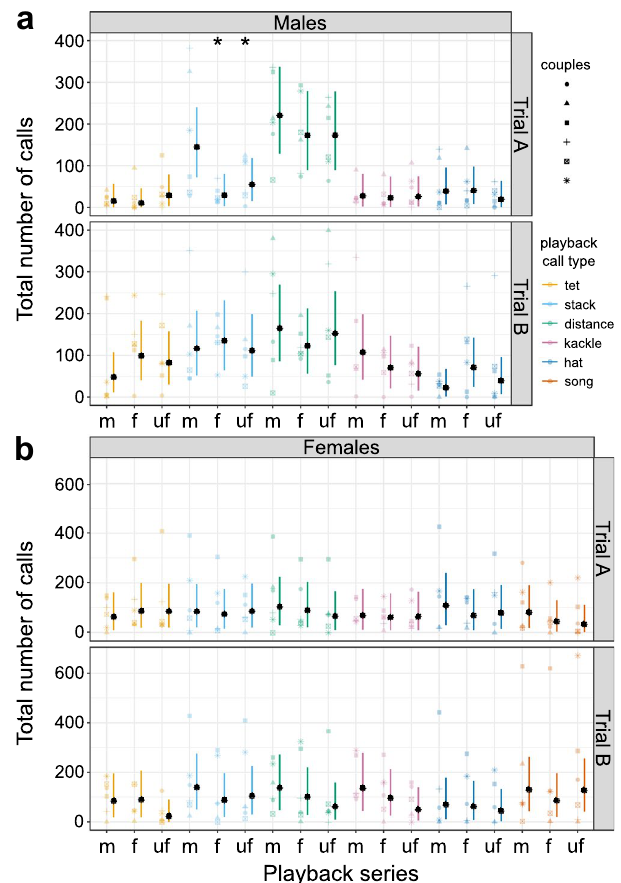
Figure 2. Number of calls during playback. Number of answering calls that focal individuals emitted during the different playback series. Raw data for males ( a ) and females ( a ) and both trials (symbols indicate responses of individual birds) and the computed 95% credible intervals (error bars) as well as the fitted value (black symbols) are shown. Colours represent the type of playback call broadcast. Familiarity categories are indicated by letters: m = mate of the focal bird; f = familiar individual; uf = unfamiliar individual. Significant differences between mate and the other familiarity categories are marked by black